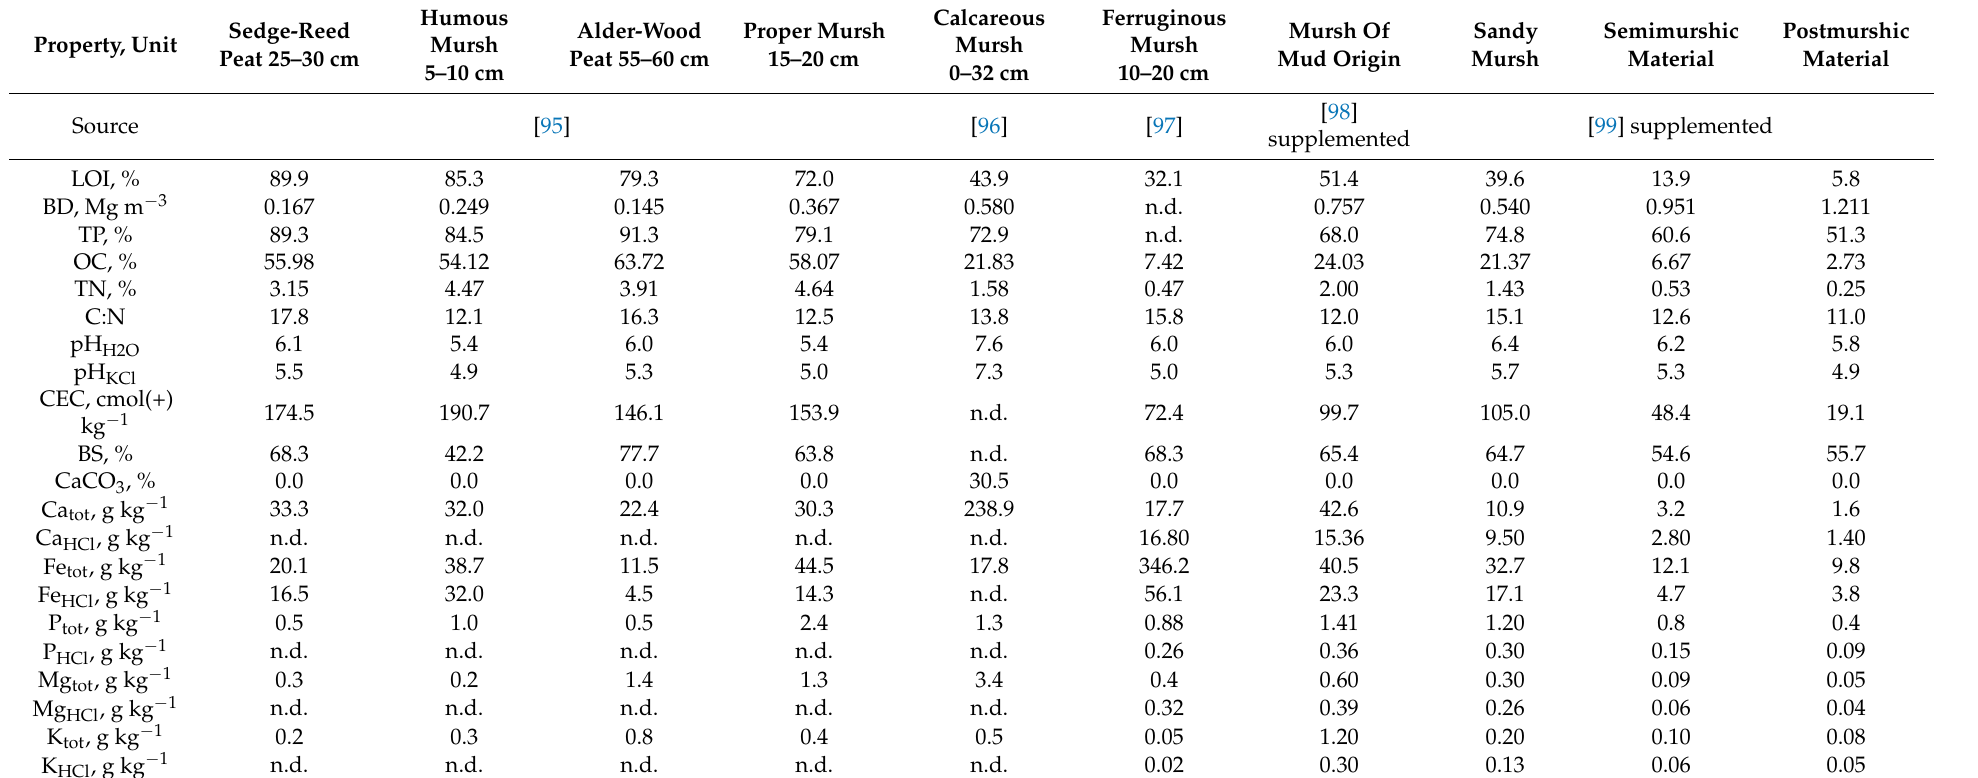
Table 2. General characteristics of soil